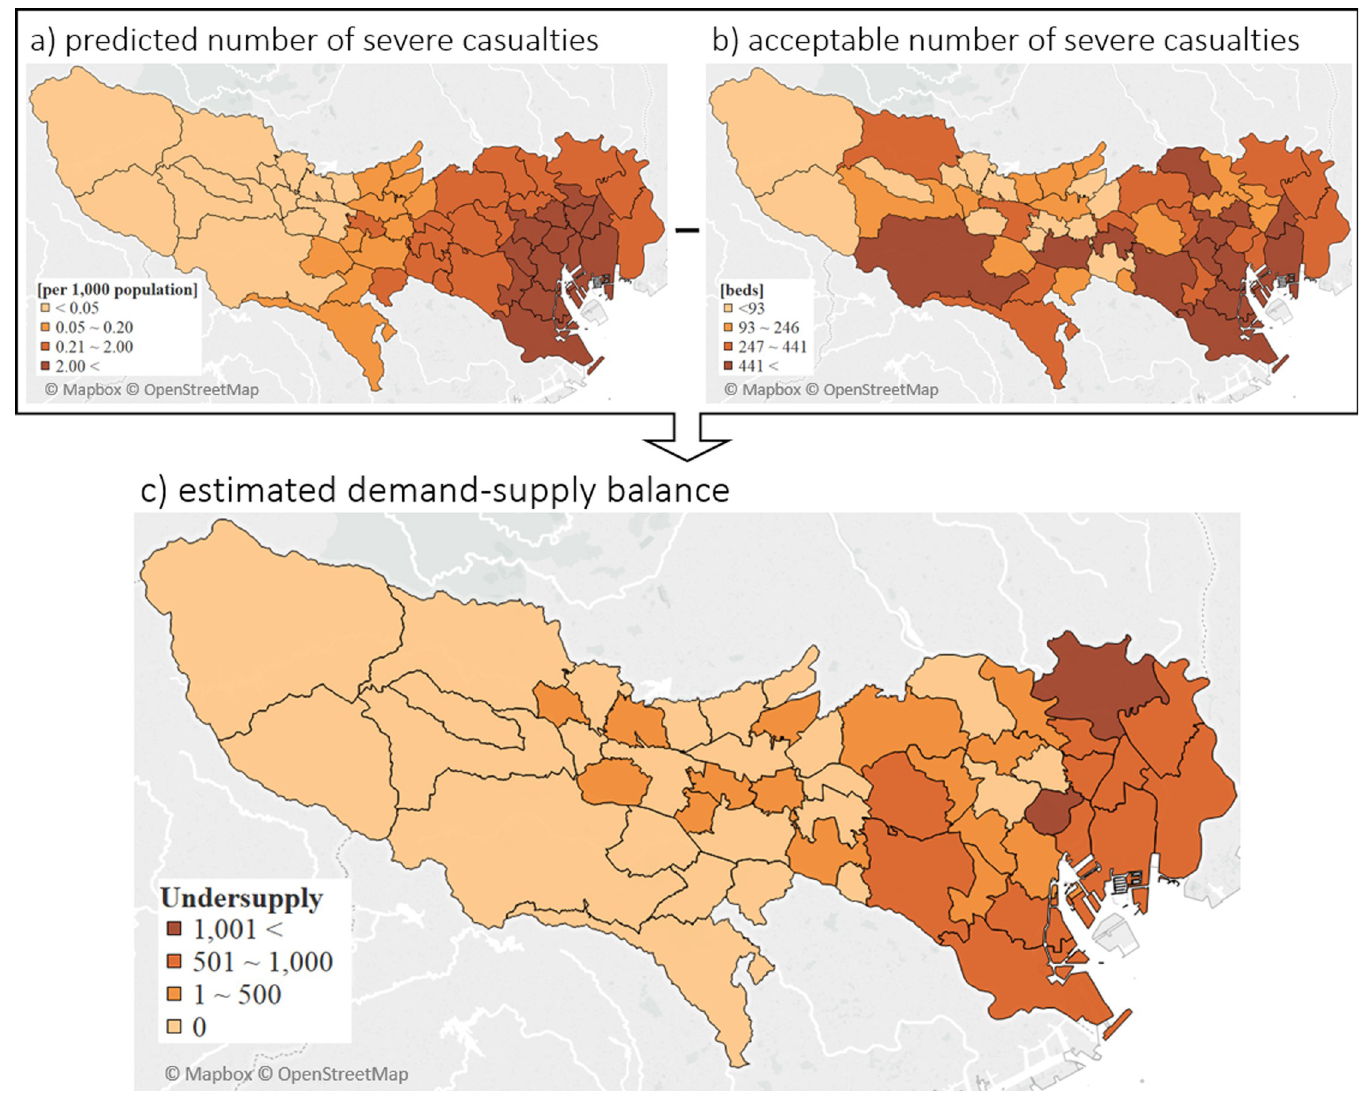
Fig 2. Geographic comparison between the predicted and acceptable number of severe casualties at the municipality level. Reprinted background map from Mapbox and OpenStreetMap under a CC BY license, with permission from Mapbox, original copyright 2020.